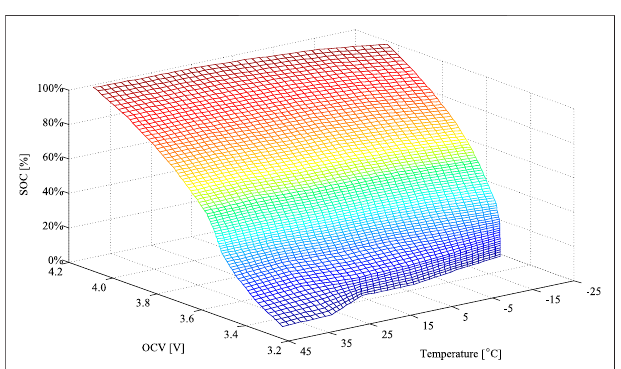
FIGURE 2 | Curved surface of the SOC versus temperature and OCV.